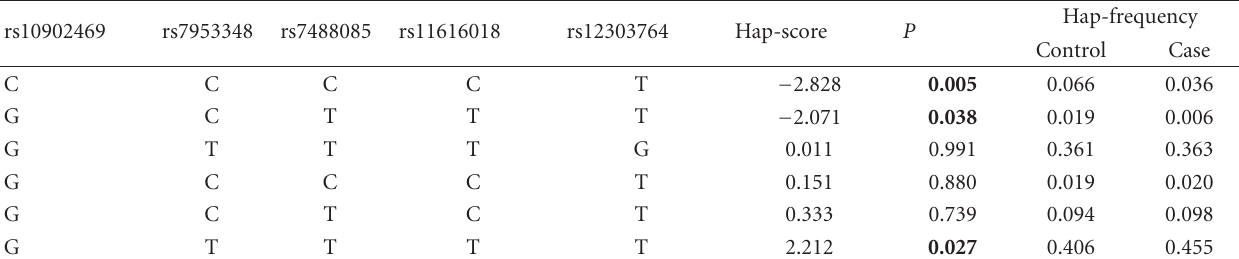
Table 4: ULK1 haplotype